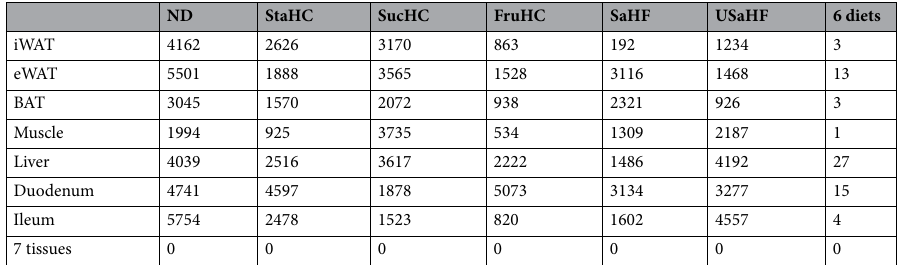
suggesting that the duodenum was affected most by gut microorganisms. Mice in the ND diet group had rela- tively more DEGs, while those in the FruHC diet group had few (ND vs FruHC, p = 0.004; ND vs SaHF, p = 0.009,